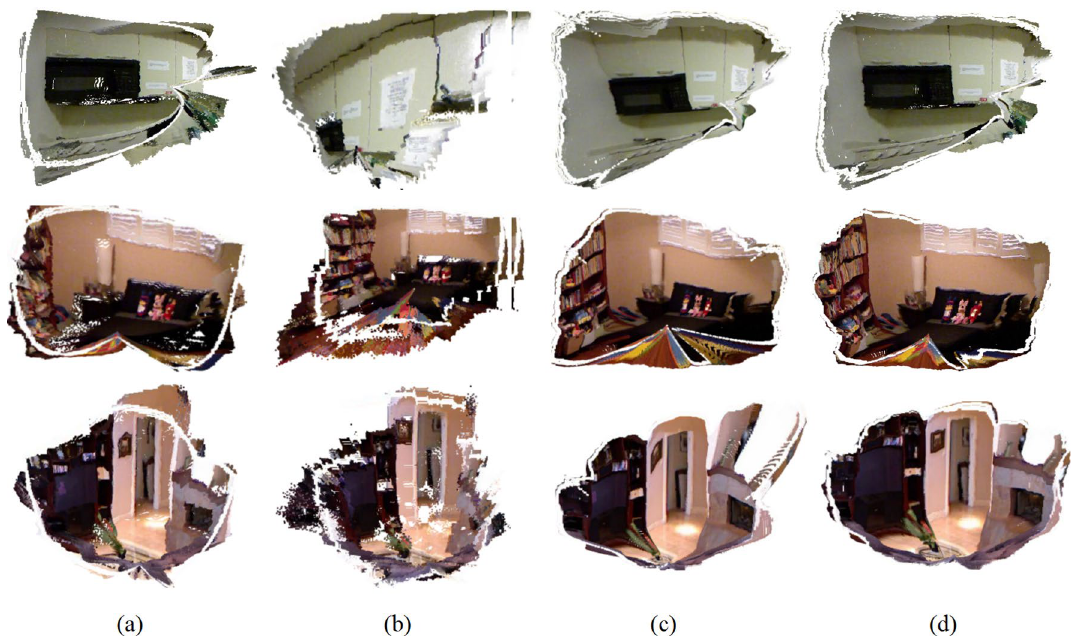
Fig. 6 The 3D reconstruction results on the NYU v2 dataset: a the ground truth, b DCNF [22], c FCRN [23] and d the proposed